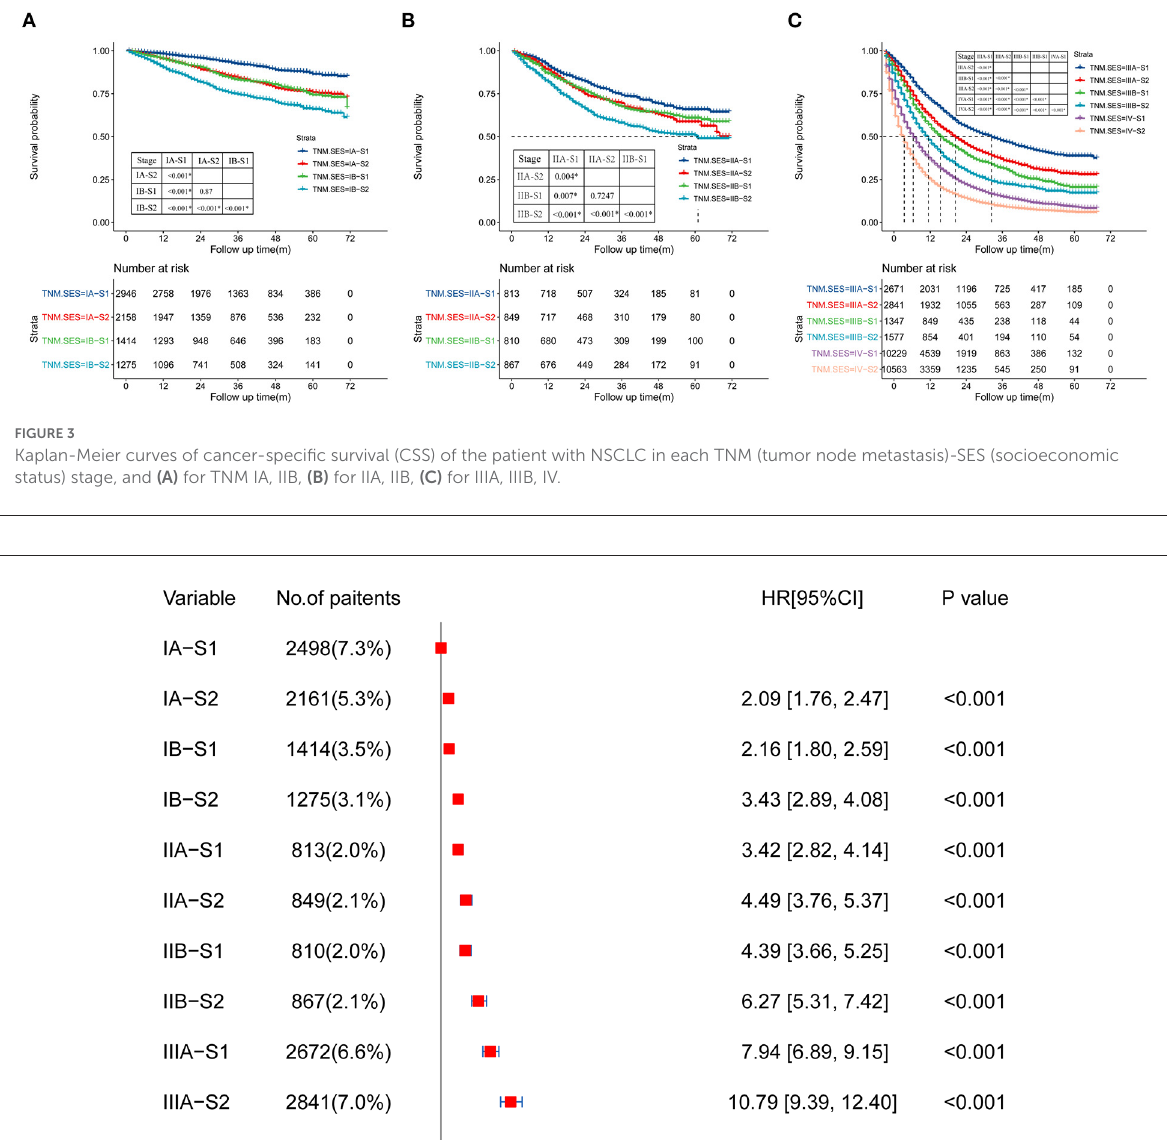
diseases, such as chronic stress, heart disease, ulcers, type 2 diabetes and cancer. In our study, we established a novel SES stage by using four SES factors associated with CSS in